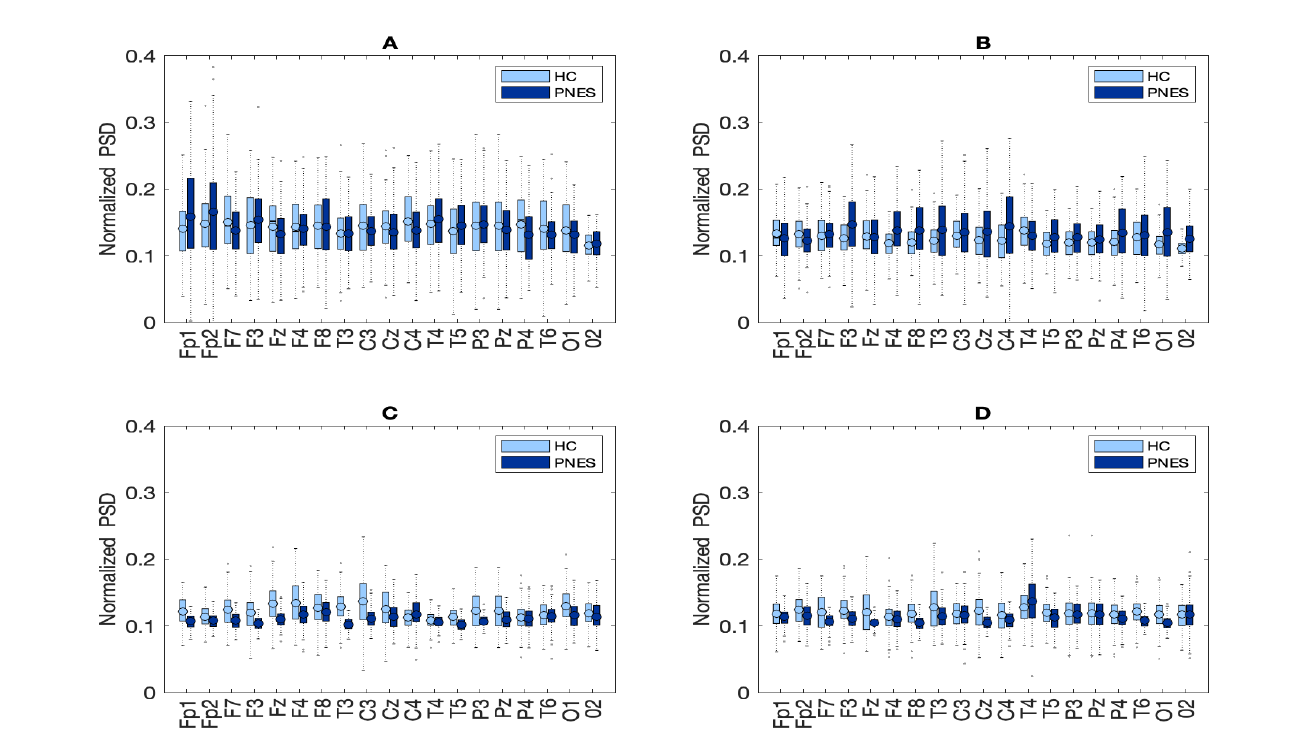
Figure 3. Box plots of normalized PSD values between pairwise of similar sensors in PNES versus HC. Panel ( A ) depict the PSD results of pairwise comparison in delta band, panel ( B ) in theta, ( C ) in alpha, and ( D ) in beta